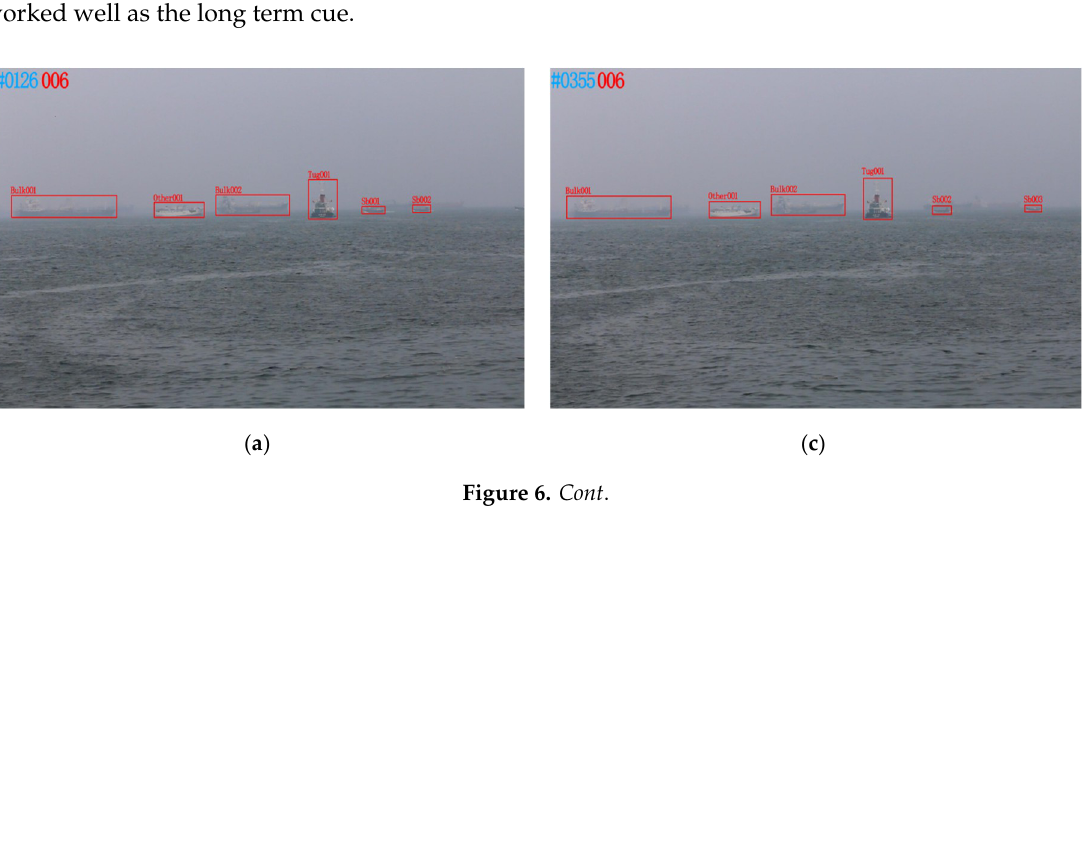
Table 2. Quantitative evaluation of different trackers on the two maritime datasets. We treated PETS 2016 as the onshore dataset considering a stationary large